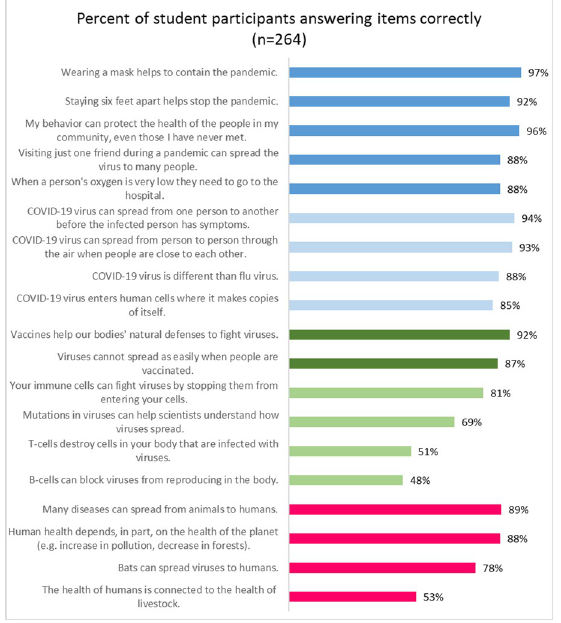
Fig 1. Percent of accurate responses to questions about COVID-19 relevant